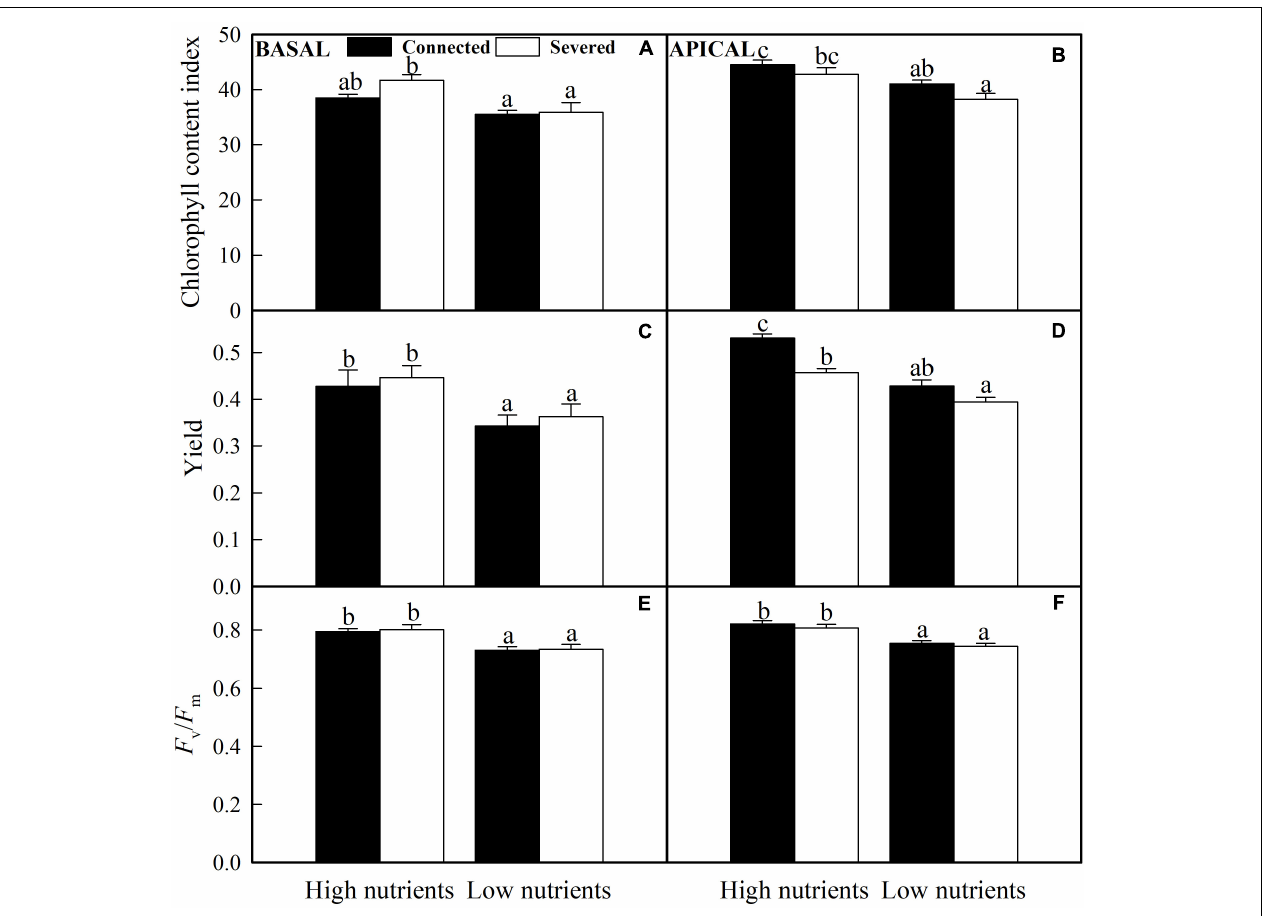
FIGURE 5 | Effects of experimental treatments on the chlorophyll content index, the effective quantum yield of PS II (Yield) and the maximum quantum yield of PSII ( F v / F m ) of basal (A,C,E) and apical (B,D,F) ramets of A. philoxeroide . The data indicate the means + SE ( n = 8). The bars sharing the same letter are not significantly different at P =